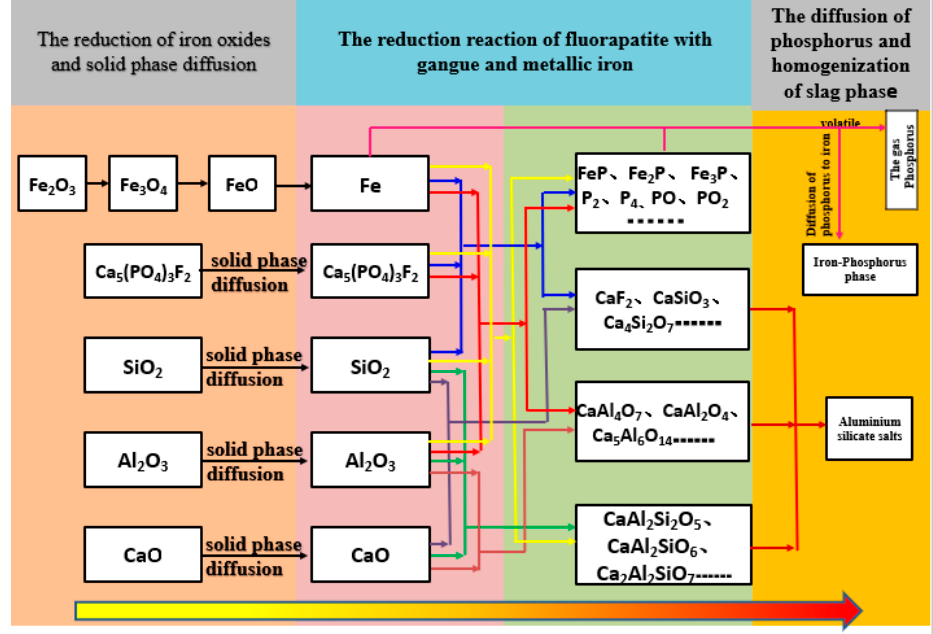
Figure 14. Relationships between the theoretical minimum temperature at which the reaction could occur and pressure.